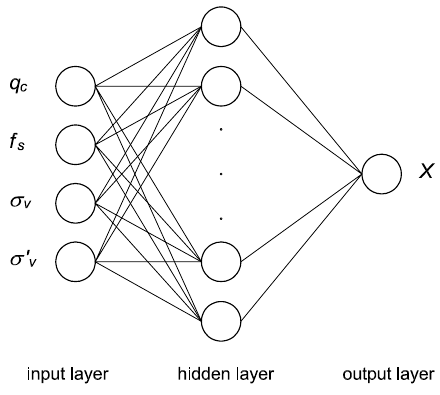
Figure 2. General scheme of artificial neural network architecture for machine learning for estimation of soil parameter X from CPT output [24].